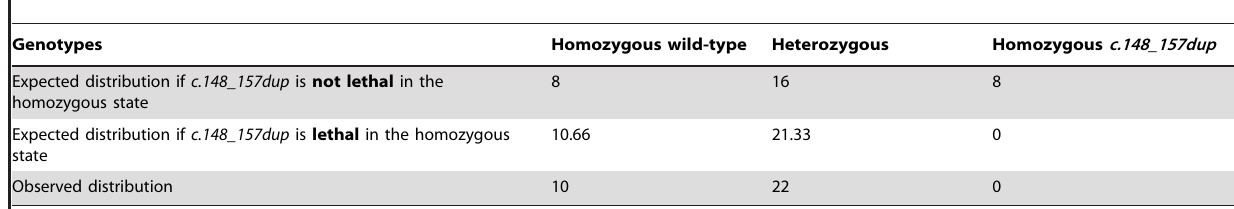
Table 1 . Results of TWIST1 c.148_157dup mutation genotyping in 32 progeny born from heterozygous